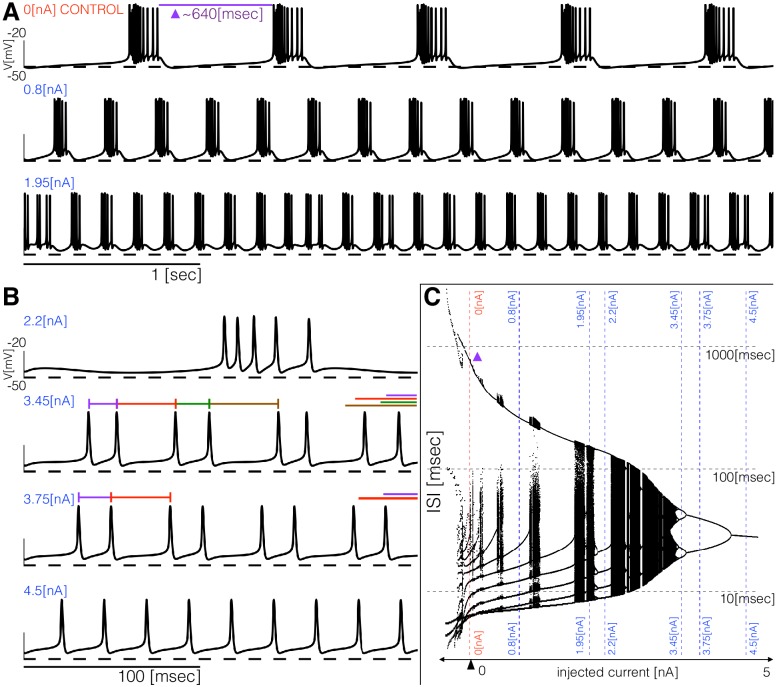
Response to current injections and interspike-intervals (ISI) distributions of model (a).(A) (top) Control traces (no current injected 0nA), regular bursting (0.8nA), irregular bursting 1.95nA. (B) (top) Fast regular bursting (fb≈6Hz), quadruplets (3.45nA), doublets (3.75nA) and singlets (4.5nA) (tonic spiking). (C) ISI distributions over a range of injected current.